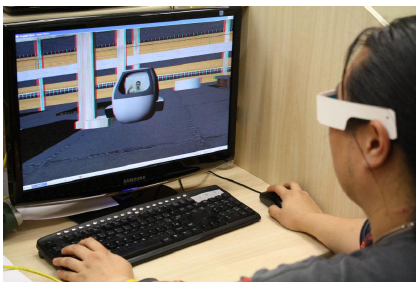
Fig. 2. User interacting with a video-avatar of a remote presenter